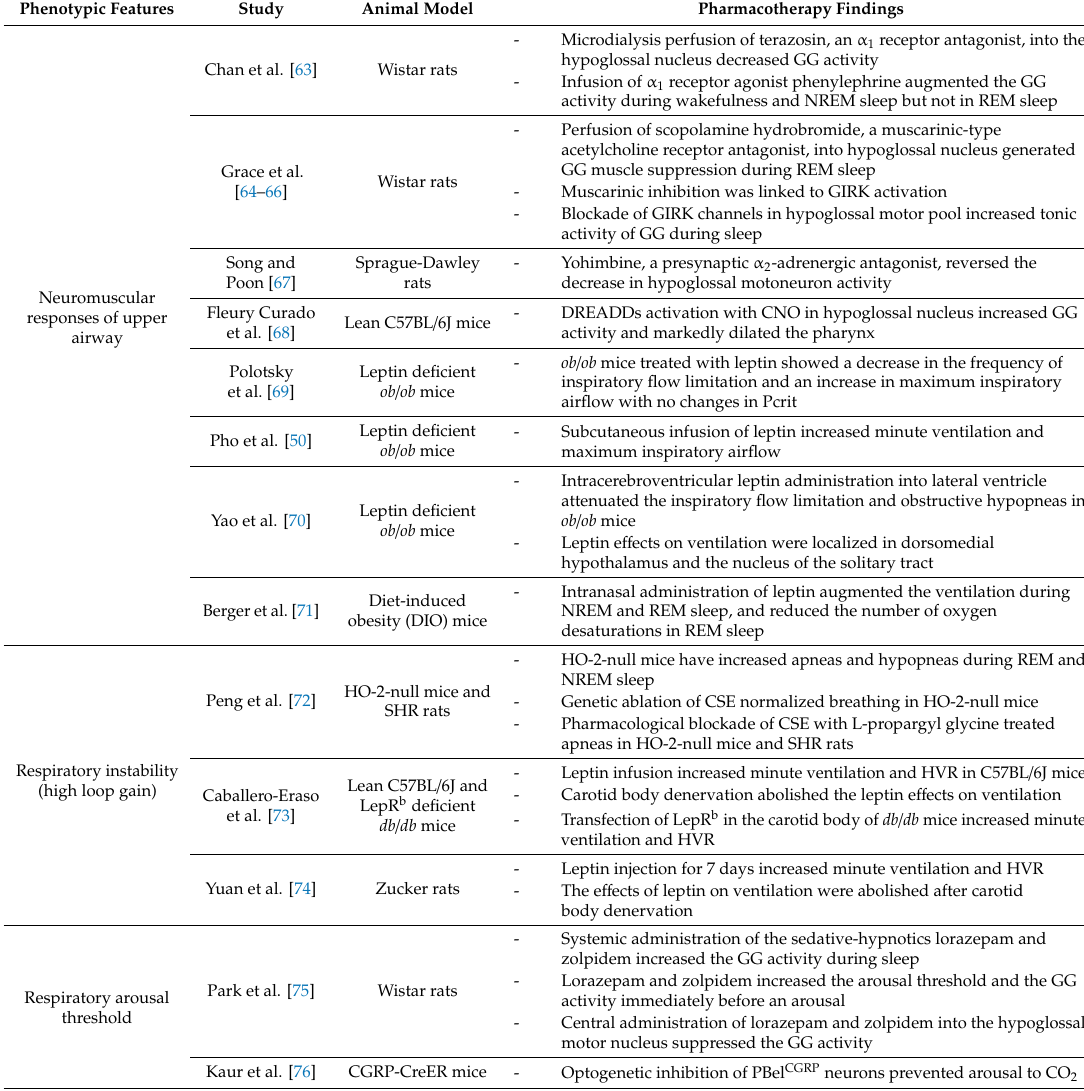
Table 1. Summary of findings about potential pharmacotherapy for obstructive sleep apnea from studies using animal